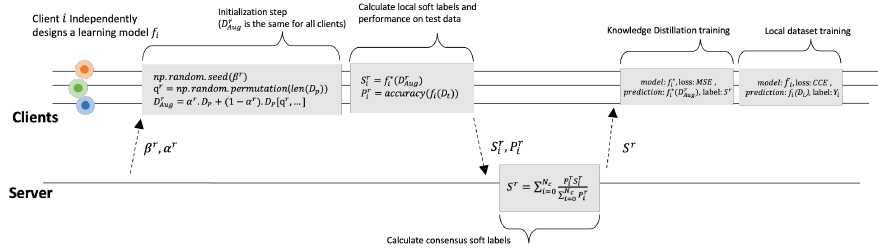
Figure 7. FedAKD timeline at communication round r . f i is the independently designed model of